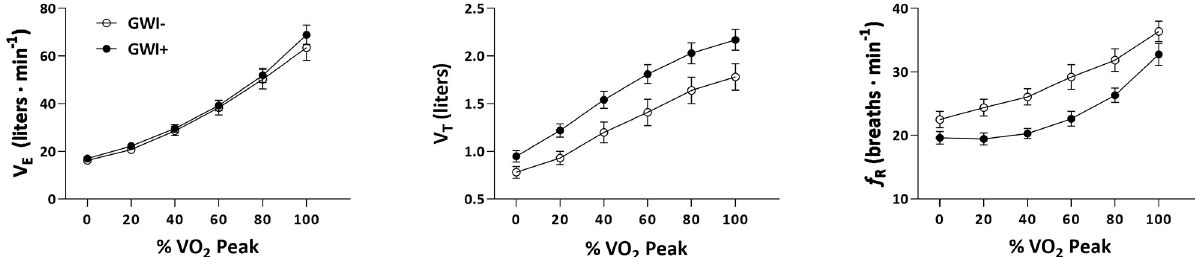
Fig 1. Time course of exercise ventilatory variables ( _ V (GWI+ = 20, GWI- = 14). Cases (GWI+) and controls (GWI-) are represented in filled and open circles, respectively. Values are mean ± SE.